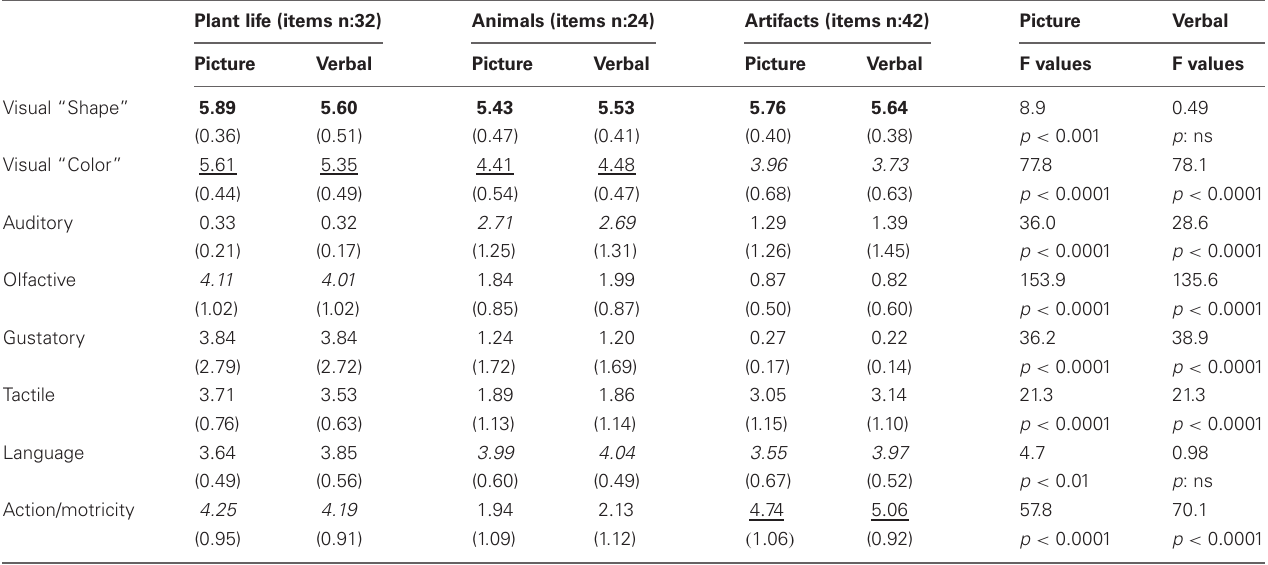
Table 2 | Mean values and Standard Deviations (in brackets) of the judgments of relevance of the various “sources of knowledge” in the domains of plant life, animals, and